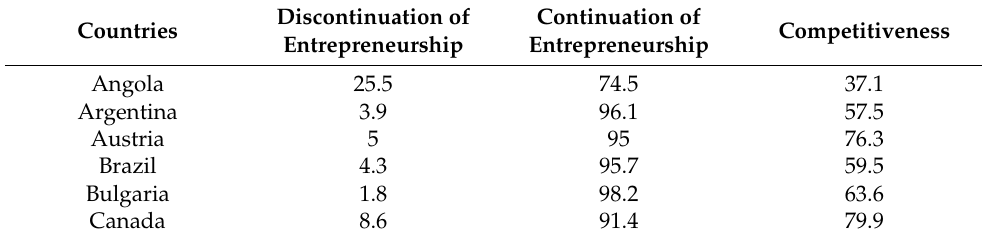
Table A4. Values of Continuation of Entrepreneurship and